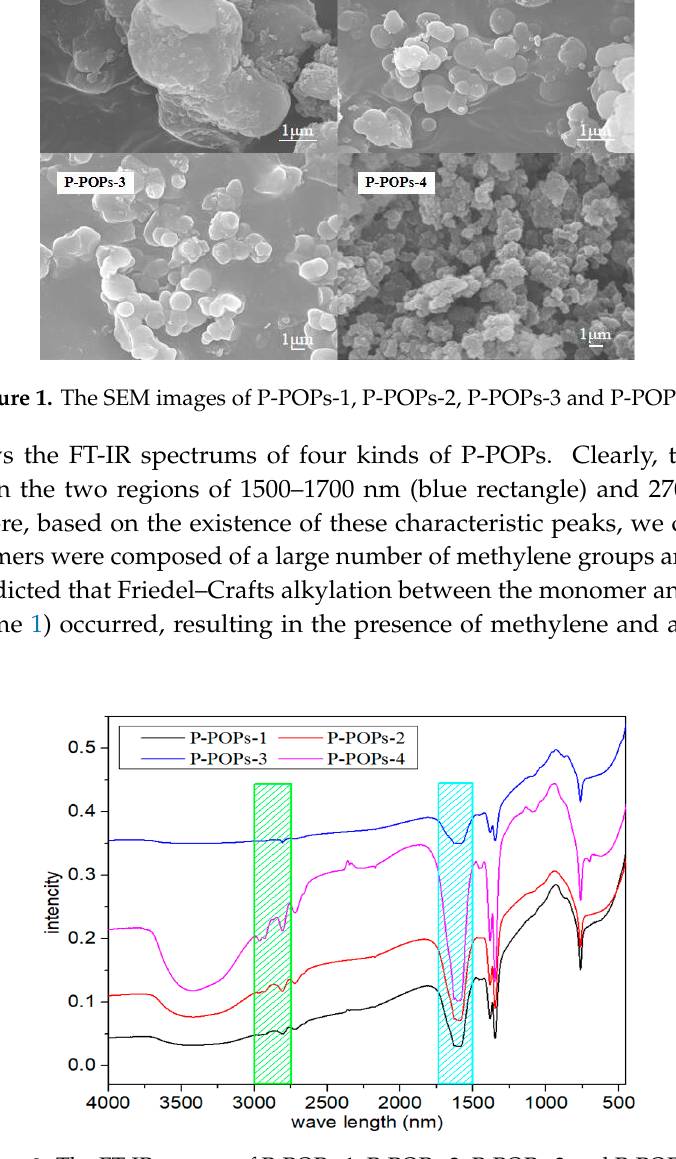
Figure 2. The FT-IR spectra of P-POPs-1, P-POPs-2, P-POPs-3 and P-POPs-4.